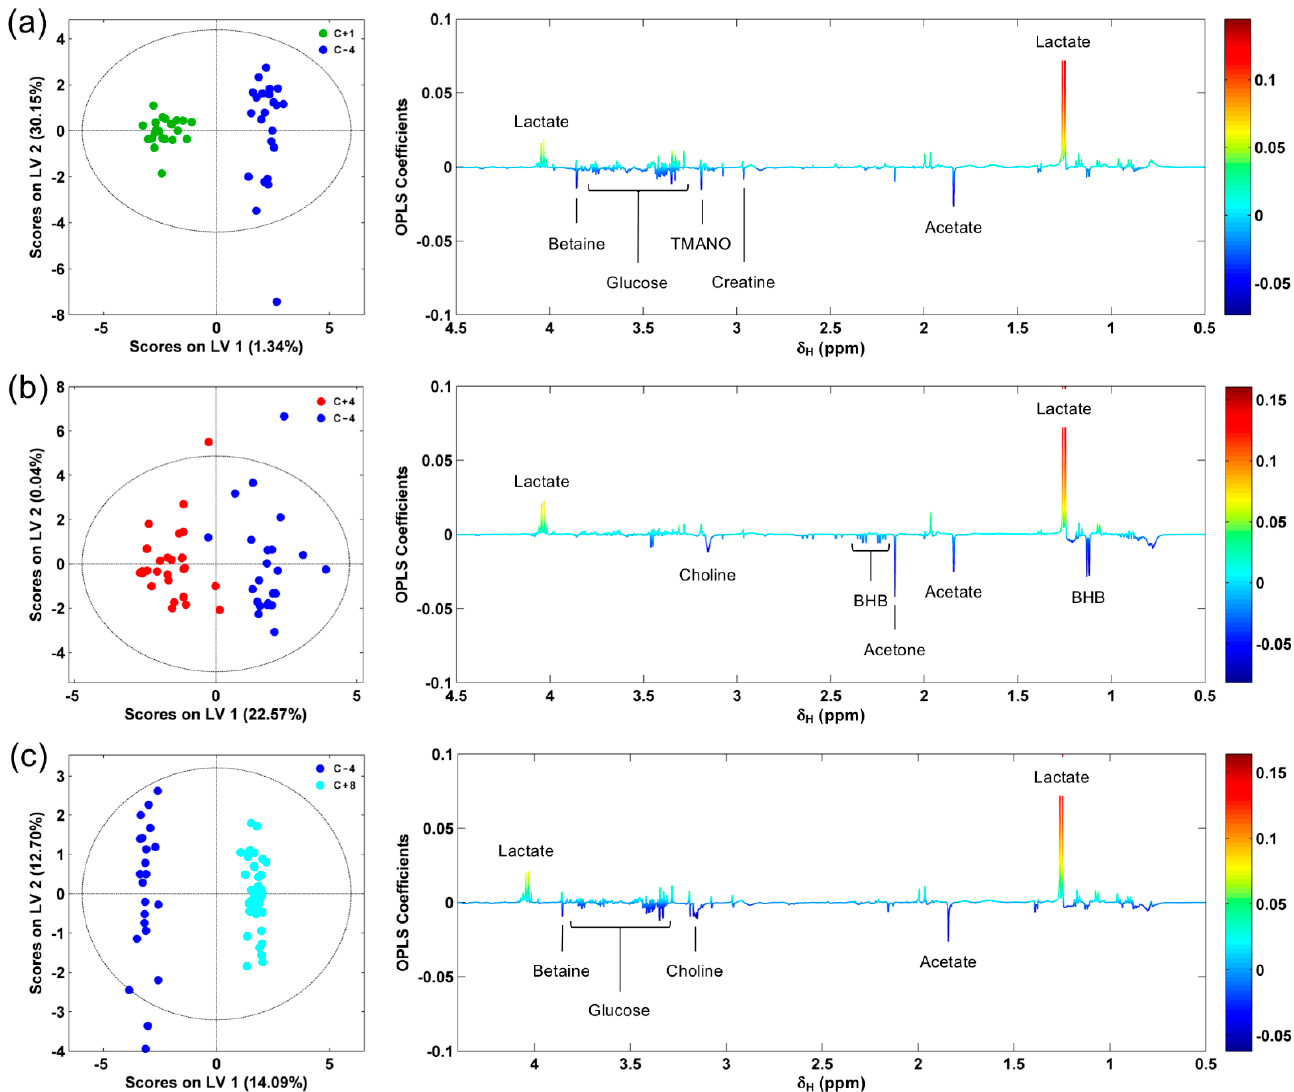
Figure 3. Score and loading factor plots obtained from the OPLS-DA between prepartum (C − 4) and first (C + 1) ( a ), second (C + 4) ( b ), and third (C + 8) ( c ) postpartum groups. The metabolites that differentiate the prepartum from each postpartum group are annotated in the loading factor plots. The R 2 Y and Q 2 Y coefficients for each model were 0.80 and 0.72, 0.89, and 0.37, and 0.94 and 0.87, respectively, and their ROC curves had AUC values of 1.00, 0.85, and 0.99 (see Figures S4–S9). As stated above, no differences based on animal parity were observed when all the data were analyzed together. However, we decided to investigate if variations related to